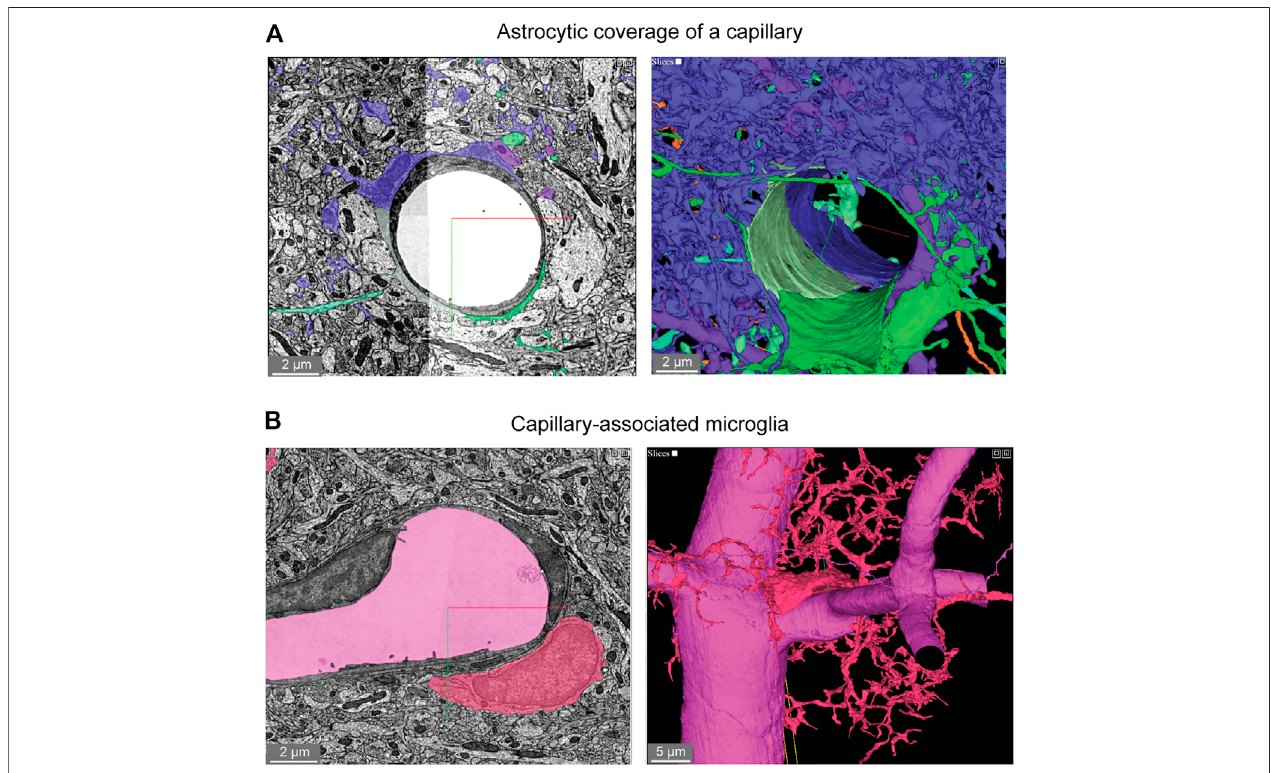
FIGURE 5 | Astroglial and microglial vascular interactions. (A) Three astrocytes (blue, green, light green) enwrap the capillary wall and their territories form a tiling pattern. Dendrites of a neuron (purple) course through the astrocytic territory. The vascular wall is not shown in the 3D view (right) to provide a clearer view of astrocyte contact with the vascular wall. MICrONS Layer 2/3 x, y, z coordinates at: 77091, 62413, 784. (B) A putative capillary-associated microglia. The 3D view shows the vascularlumen infuchsiaand amicroglial soma(red) thatdrapes alongthevessel surfaceat abifurcation. Closeinspectionofthismicroglia willreveal thatitdirectly contacts the vascular basement membrane without intervening astrocytic endfeet. MICrONS Layer 2/3 x, y, z coordinates at: 76302, 59416, 1641.